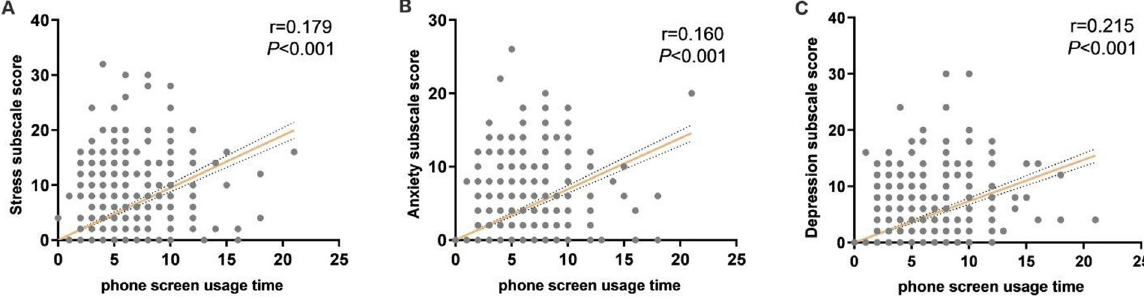
Fig 3. Correlation analysis between mobile phone screen use time and negative emotions of college students. Correlation analysis between mobile phone screen use time and stress of college students; (b)Correlation analysis of mobile phone screen time and anxiety among college students; (c)Correlation analysis of mobile phone screen use time and depression in college